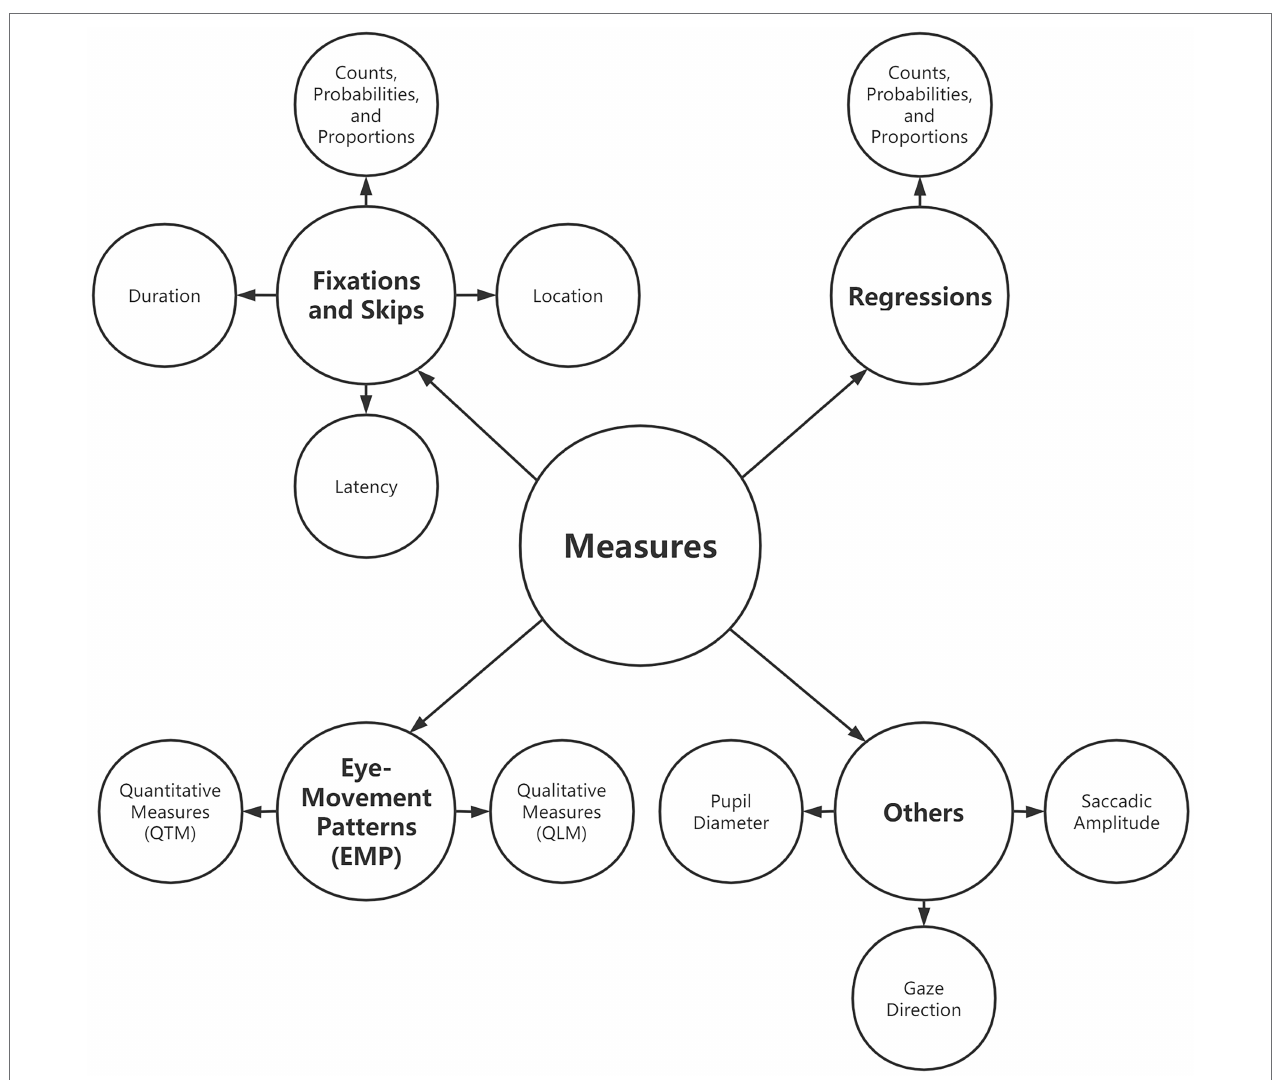
FIGURE 6 | Taxonomy of